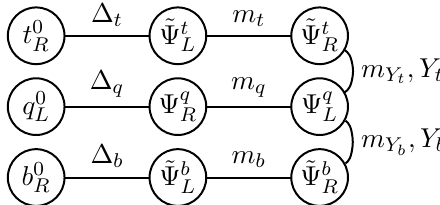
Figure 1. Structure of couplings between elementary and composite resonances. For the M4DCHM 5 − 5 − 5 , the left-handed elementary quark doublet q 0 composite multiplets Ψ t and Ψ b , which respectively couple to ˜Ψ t and ˜Ψ b with independent inter- action